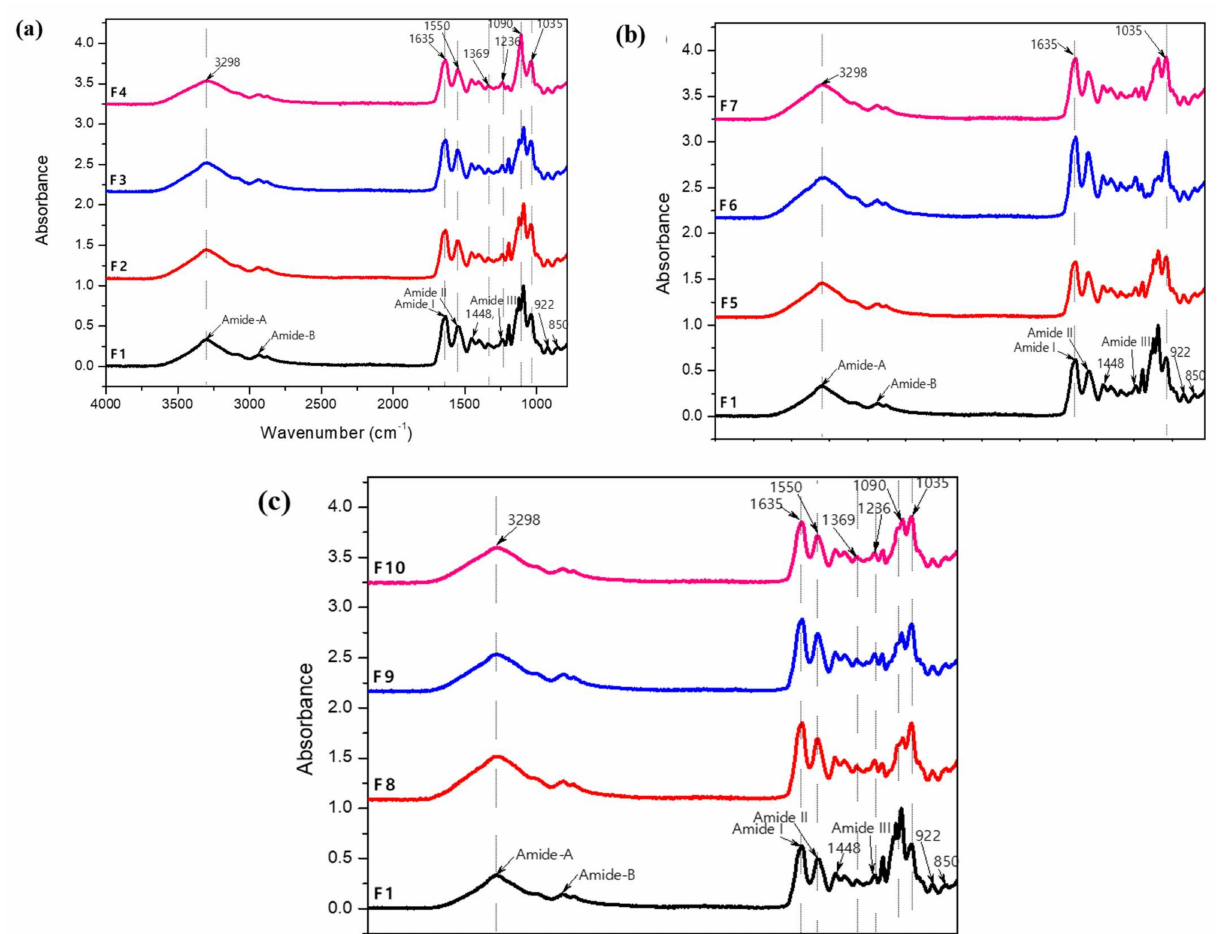
Figure 3. Fourier Transform Infrared Spectroscopy (FTIR) results of the reinforced gelatin biofilms. ( a ) Spectra of biofilms F1 to F4, ( b ) spectra of biofilms F1, F5 to F7 and ( c ) spectra of biofilms F1, F8 to